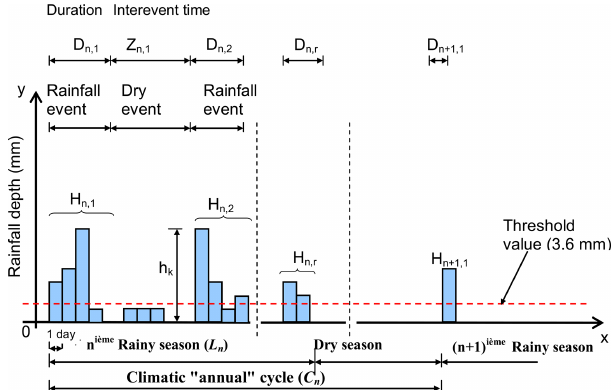
Figure 2. Event representation of the climatic cycle.